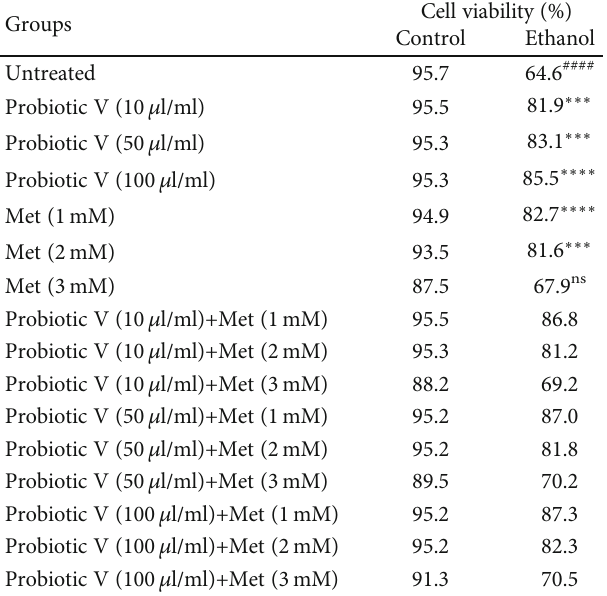
Table 4: E ff ect of probiotic V and Met on the viability of HepG2 cells. The average percentage of cell viability after respective treatment was analyzed through MTT assay. Values represent the mean ± SD of three individual experiments. Statistical signi fi cance was assessed by one-way ANOVA followed by Tukey post hoc test. Statistical analysis: #### p < 0 : 0001 compared with control untreated group; ∗∗ p < 0 : 01 , ∗∗∗ p < 0 : 001 , and ∗∗∗∗ p < 0 : 0001 compared with ethanol alone; ns stands for nonsigni fi cant.